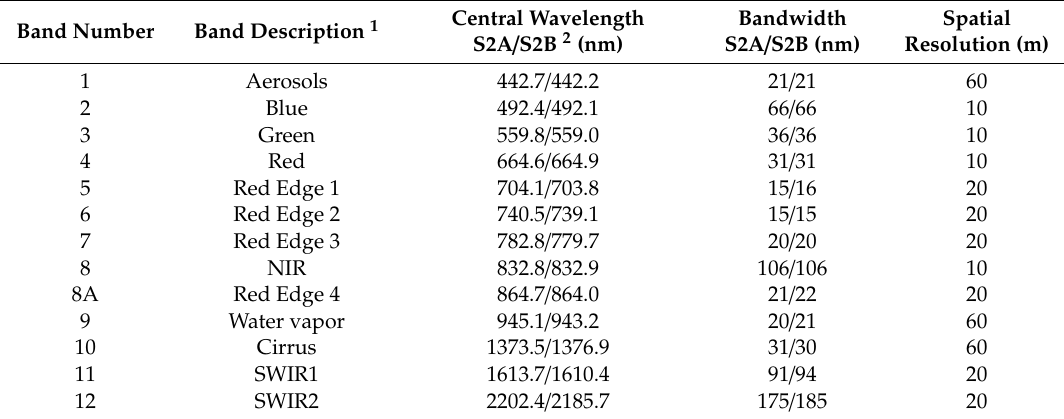
Table 2. Sentinel-2 Multispectral Instrument (MSI) spectral bands at 10 m, 20 m and 60 m spatial resolution.